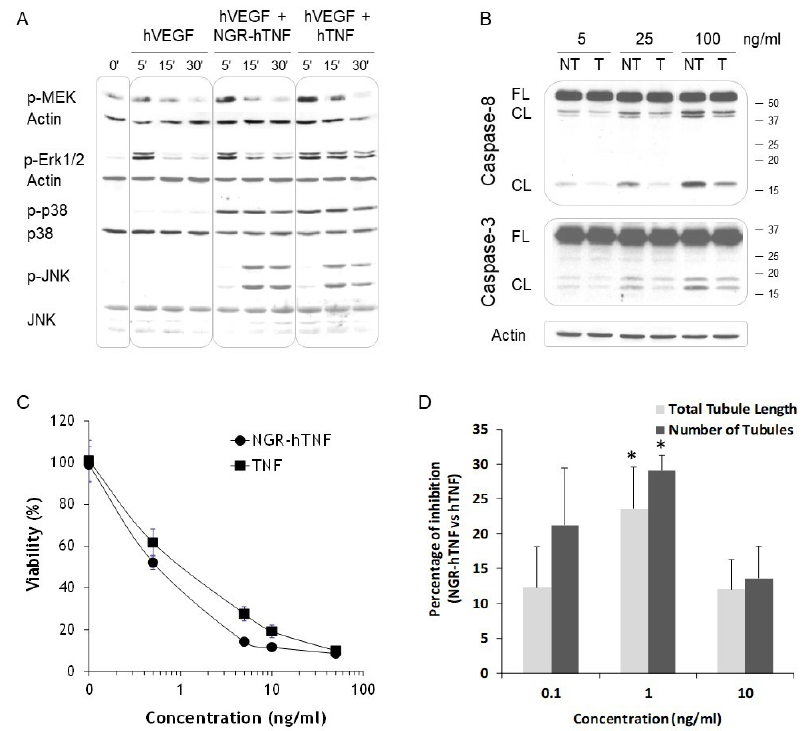
Figure 6. Cell signaling and cytotoxicity of NGR-hTNF and hTNF, in HUVEC. ( A ) Starved HUVEC cells were stimulated with NGR-hTNF or hTNF in the presence of hVEGF (as described in Section 4), and their lysates analyzed for phosphorylation of the reported kinases. Actin, p38 and JNK blots were performed, after stripping, as a loading control. A representative experiment out of three is shown. ( B ) Starved cells were incubated for 30 min with NGR-hTNF (NT) or hTNF (T) and analyzed after 4 h. The fragmentation of Caspases 8 and 3 was detected with antibodies that recognize the full length (FL) and the cleaved (CL) forms. Actin blot was performed as a loading control. Molecular mass markers (kDa) are shown to the right of the blots. One representative experiment out of two is shown. ( C ) Cytotoxicity of wild type and recombinant hTNF was tested on HUVEC as described in Materials and Methods. One representative experiment out of five is shown (mean ± SE). ( D ) Comparison between NGR-hTNF and hTNF effects on capillary-like structures formation by HUVEC was performed with an in vitro test (as described in Section 4). At day 10, the cells were stained with an anti-CD31 Ab and tubule images analyzed for the quantification of total tubule length, and the number of tubules. The results are expressed as a percentage of the decrease induced by NGR-hTNF over hTNF. A representative experiment out of two is shown (mean ± SE; * p < 0.05).